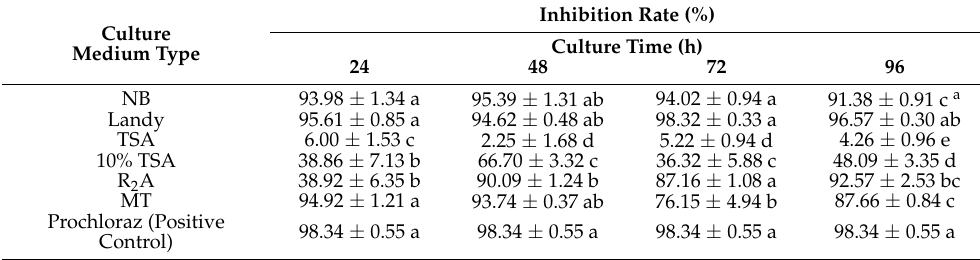
Table 2. Effect of Bacillus subtilis L1-21 culture filtrate on spore germination of pathogen.